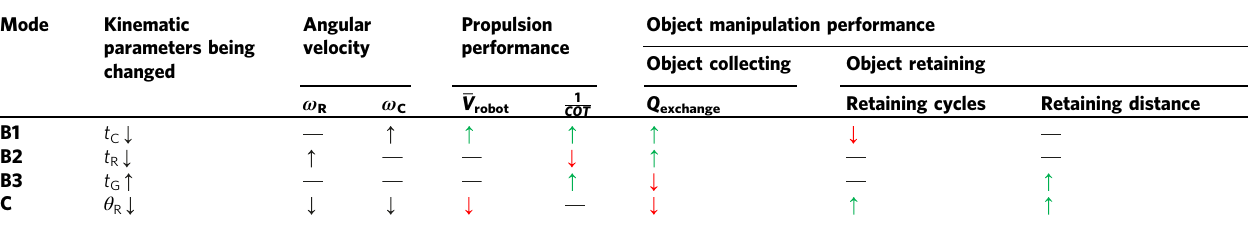
Table 1 Summary of propulsion and object manipulation performances of different basic swimming modes